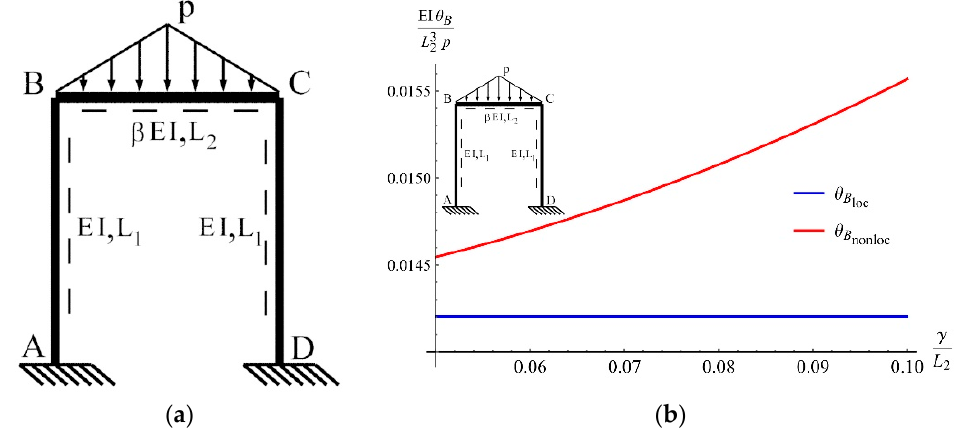
Figure 12. ( a ) The frame subjected to the two triangular loads ( p ) ; ( b ) the variation of rotation ( θ B ) at point B.